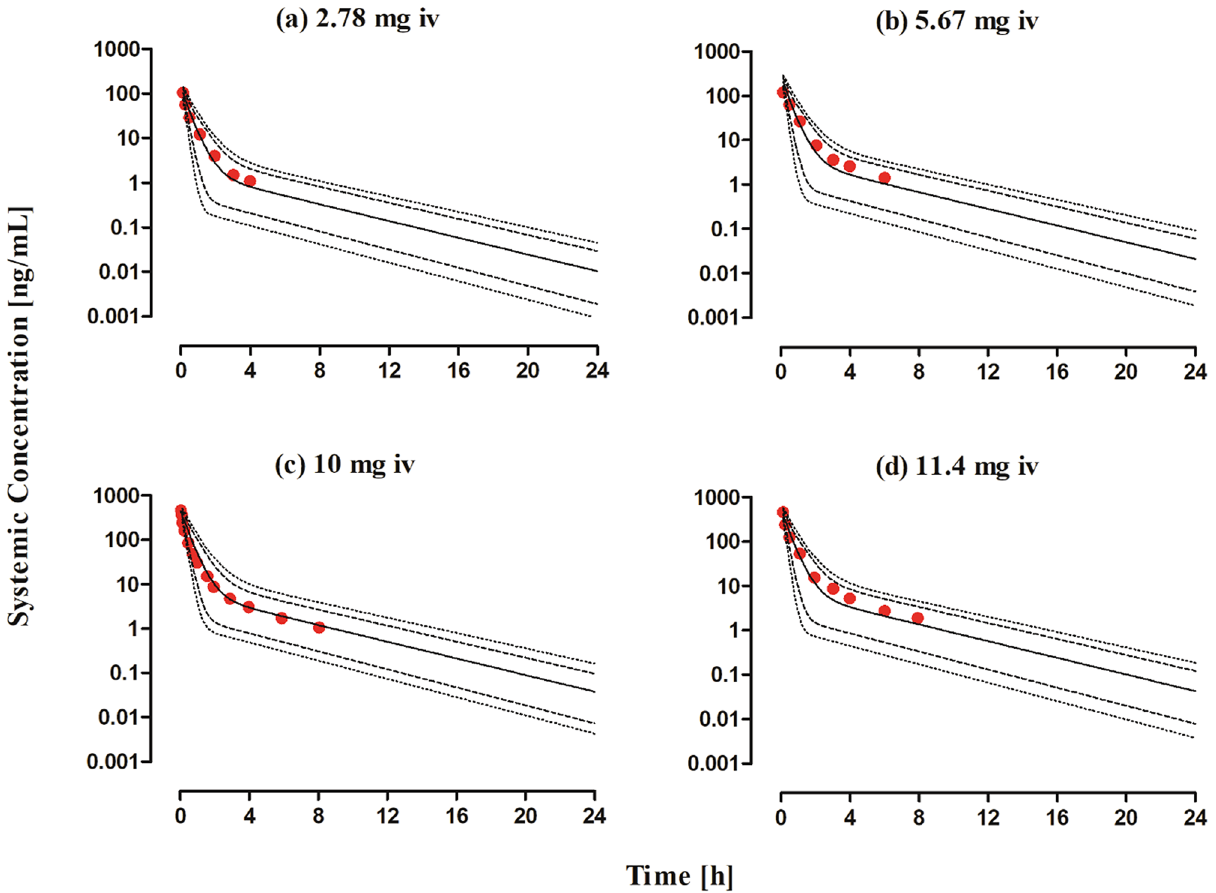
Figure 2. Observed and predicted systemic concentration profiles of captopril in healthy adults after iv bolus administration. ( a ) 2.78 mg, ( b ) 5.67 mg, ( c ) 10 mg 25 and ( d ) 11.4 mg 18 . The observed data are shown as (red circles). The predicted results are shown as mean (solid line), maximum value, and minimum value (dashed line) and the 5th–95th percentiles (dotted